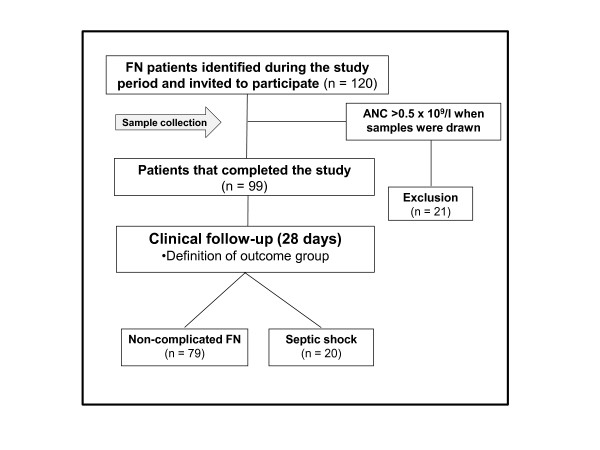
Study flowchart.